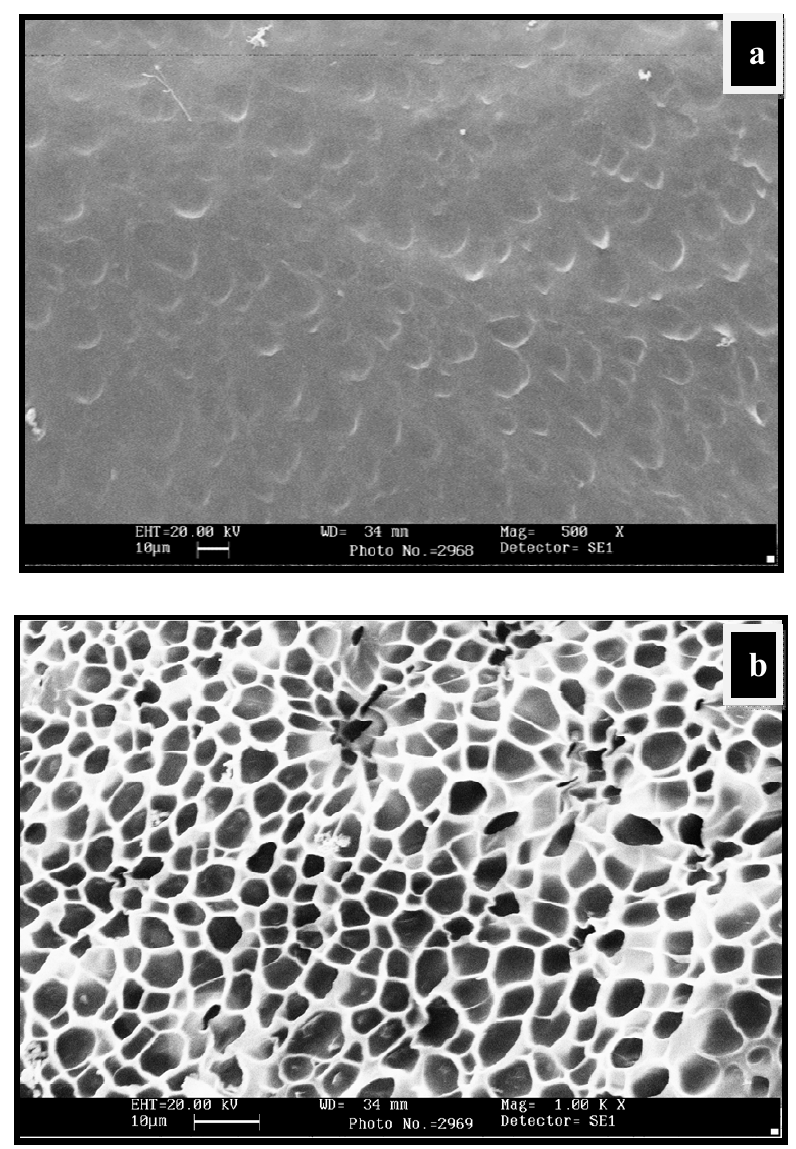
Figure 4. SEM micrographs of water-swollen CGP2-5: ( a ) Swollen structure at magnification 500 × ; ( b ) swollen structure showing the interpenetrating network at magnification 1.00K ×.